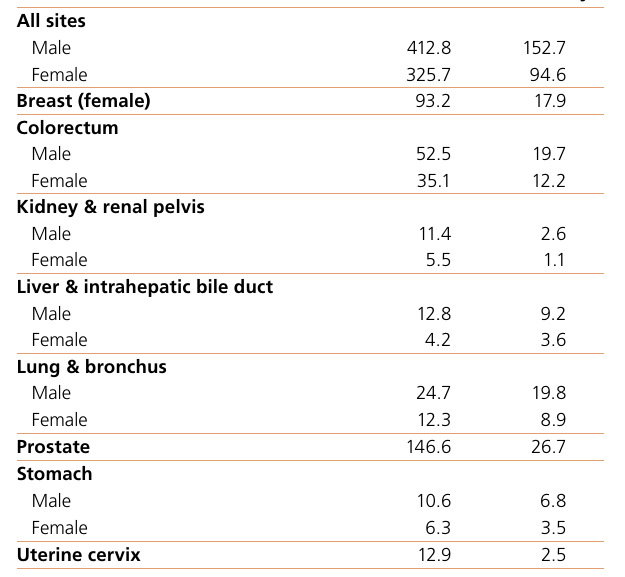
Table 4. Cancer Incidence and Death Rates for Selected Cancers, Puerto Rico,